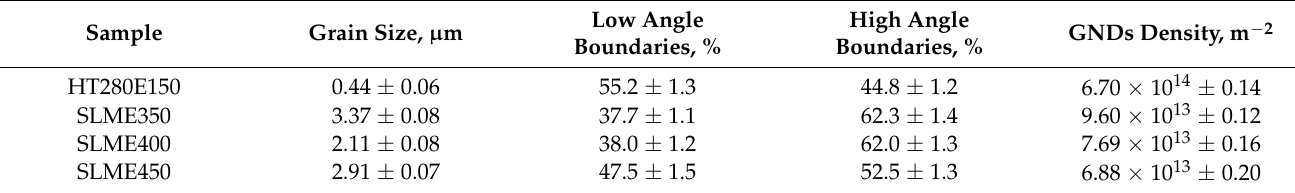
Table 2. Microstructural parameters obtained from EBSD